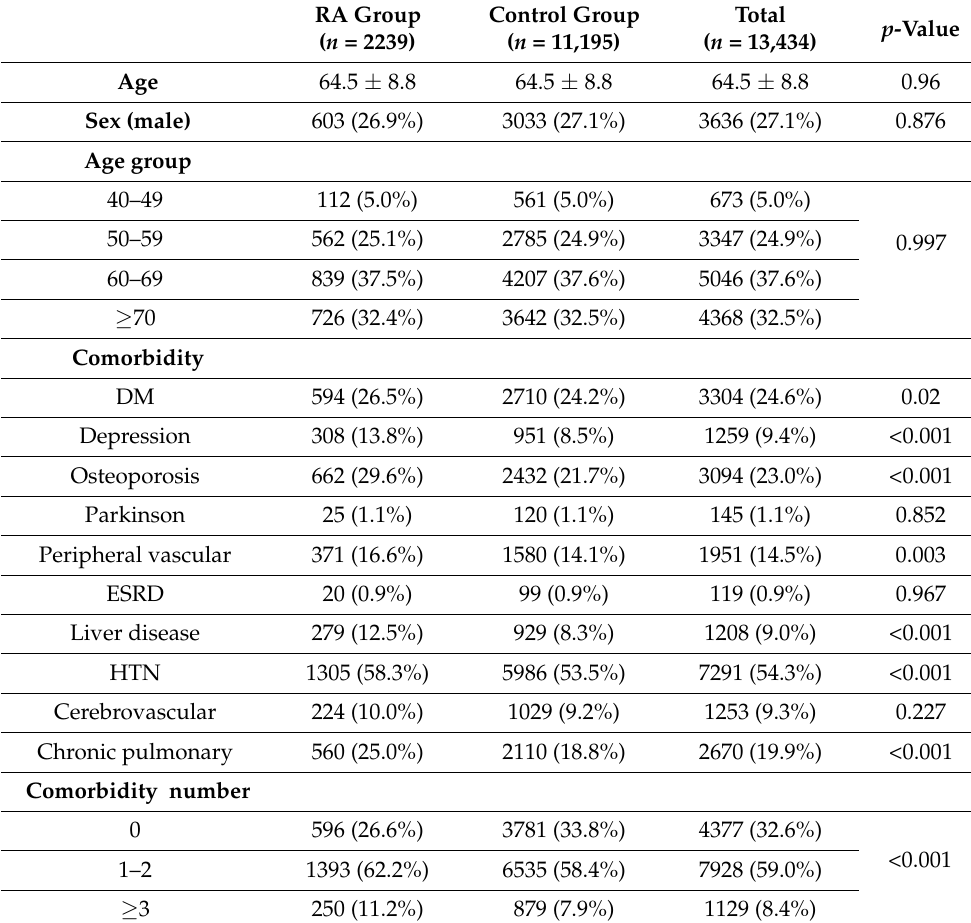
Table 1. Comparison between the demographic characteristics and comorbidities of rheumatoid arthritis (RA) patients and the control